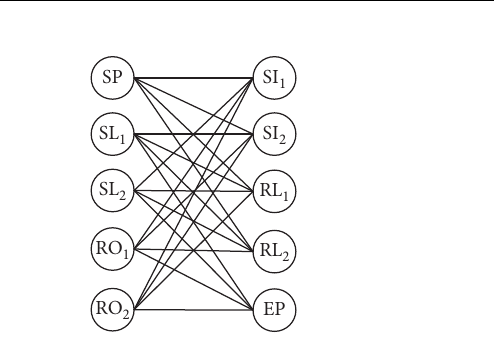
Figure 3: Bipartite graph with two storage requests and two re- trieval